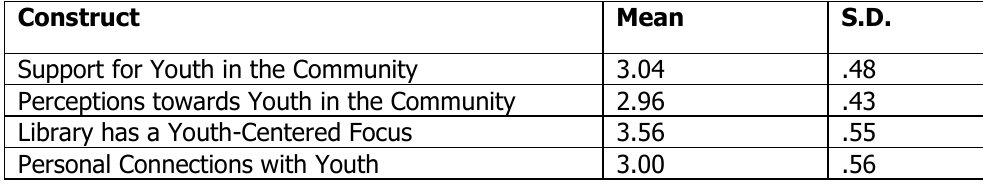
Perceptions of Library Staff toward Youth in the Local Library (n = 239) Construct Mean Support for Youth in the Community Perceptions towards Youth in the